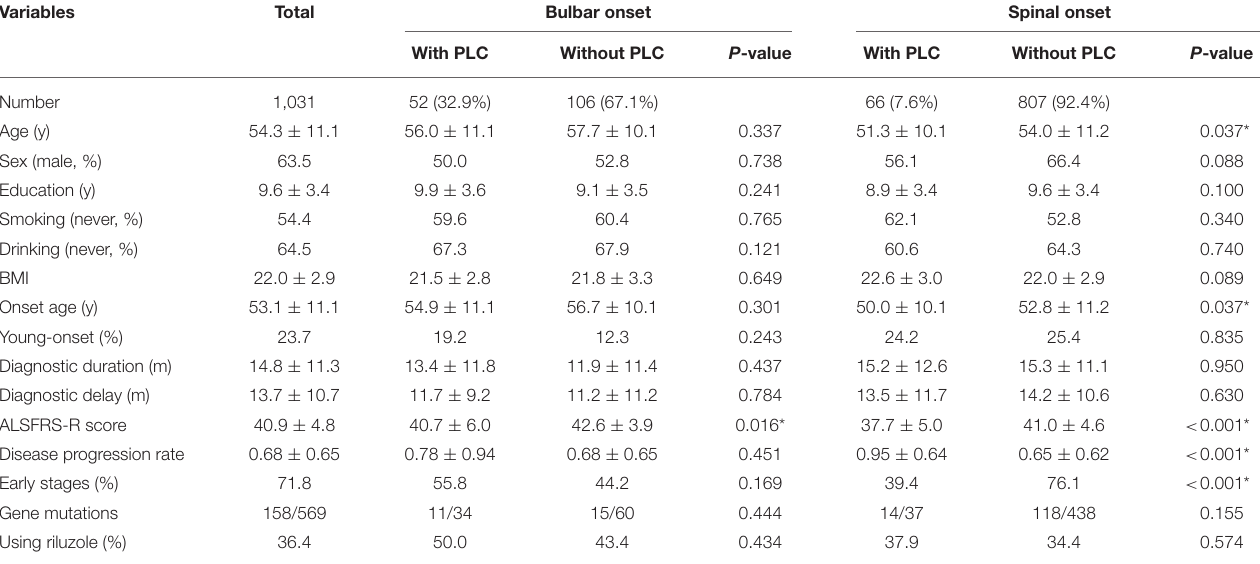
TABLE 1 | Demographic and clinical features of ALS patients with and without PLC. Variables Total Bulbar onset Spinal onset With PLC Without PLC P -value With PLC Without PLC P